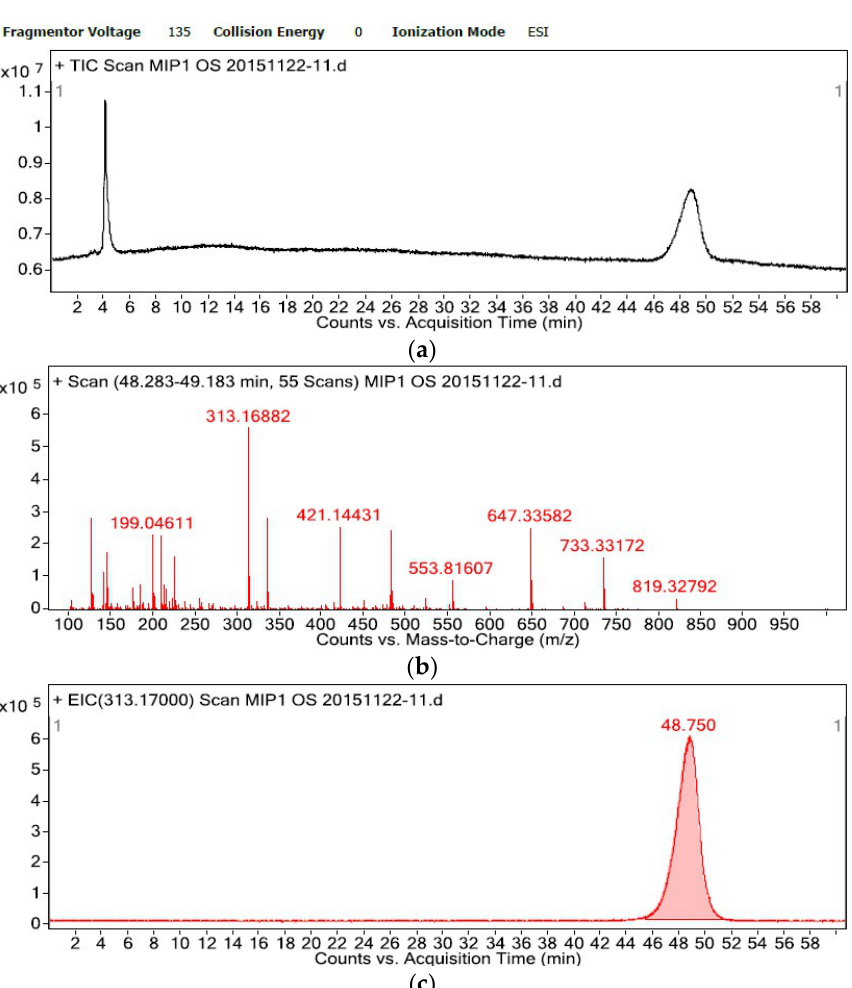
Figure 5. Spectra of OS standard solution on the OSMIP@silica gel column ( a ) TIC, ( b ) MS spectrum from 48 to 49 min, ( c ) EIC of m / z 313.17).